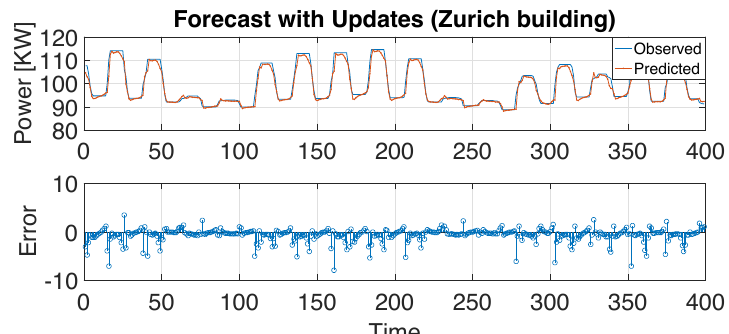
Figure 6. Building load forecasting with 50 unit RNN LSTM: Zurich.